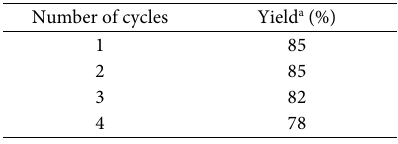
O MNPs catalyst. 3 4